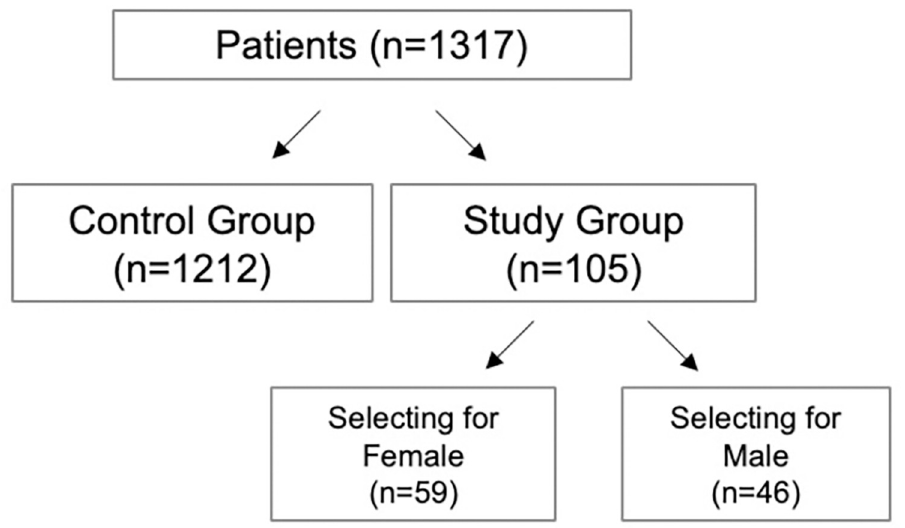
Fig 3. Patient flowchart. A total of 1,317 couples undergoing ICSI cycles with preimplantation genetic testing were included in our study. Couples (n = 1,212) who did not desire a specific offspring sex underwent ICSI cycles with PGT-A solely for aneuploidy, while the remaining 105 elected to undergo ICSI with PGT-A for sex selection.